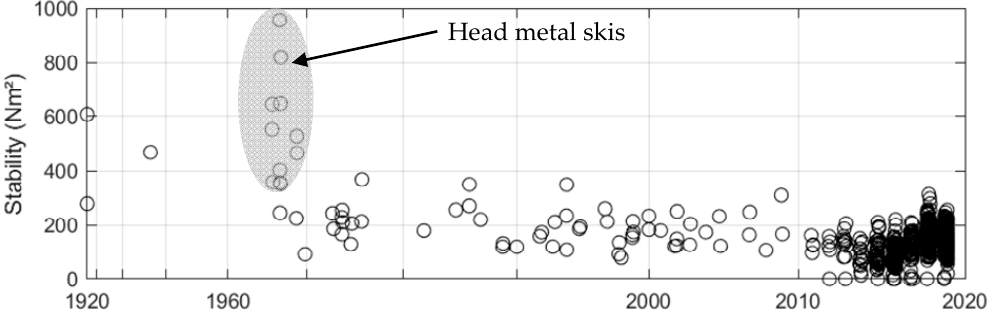
Figure 9. Directional stability estimated at a lateral lean angle of